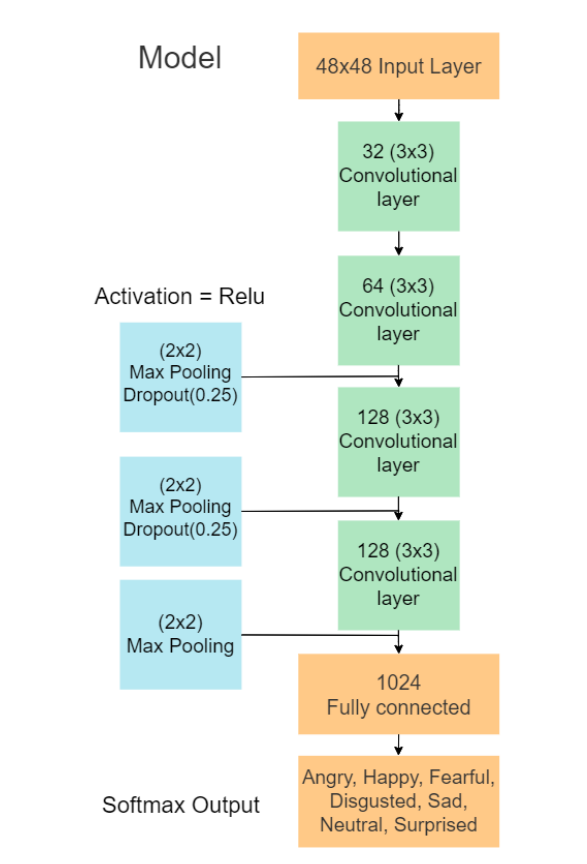
Fig. 2. Structure of CNN model used for training.